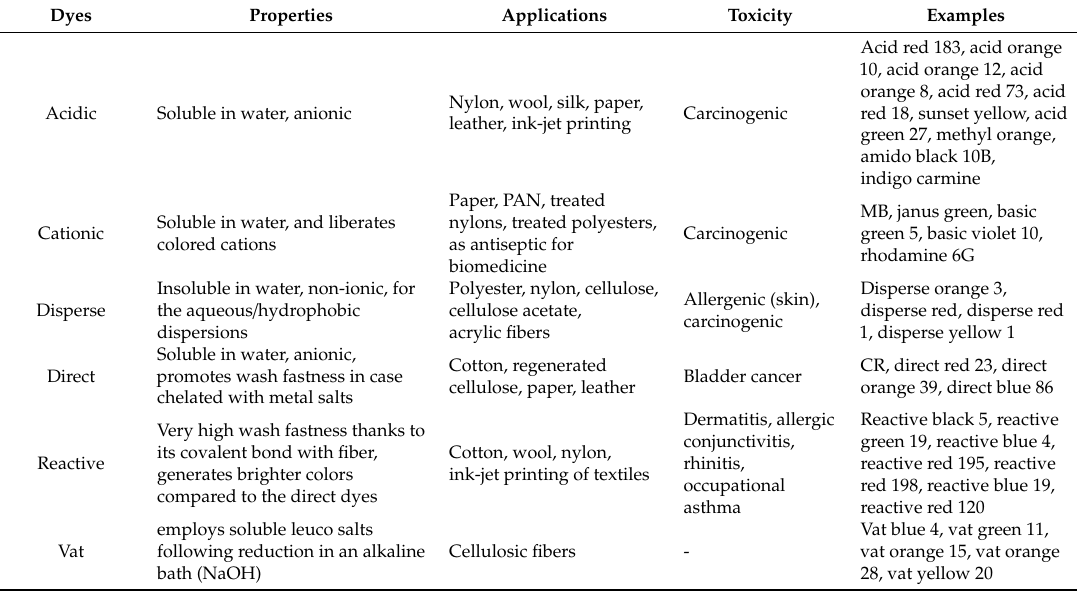
Table 1. Classification of dyes and their corresponding properties, applications, and toxicities (Reproduced with permission [5]. Copyright 2015,